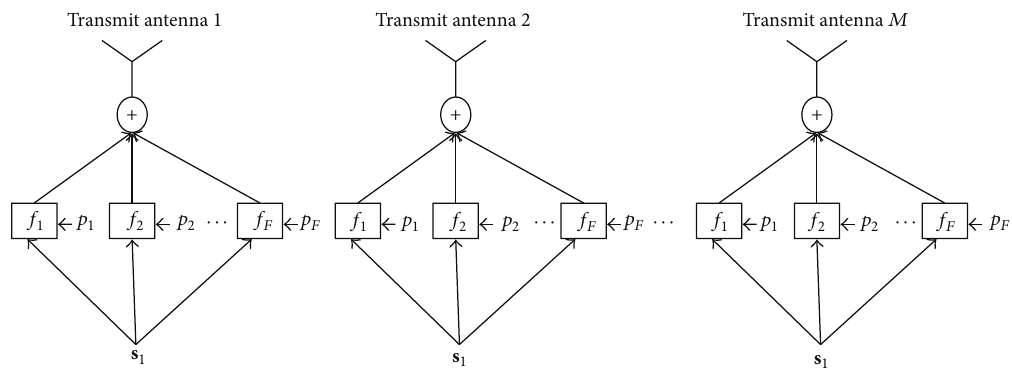
Figure 1: The structure of transmit